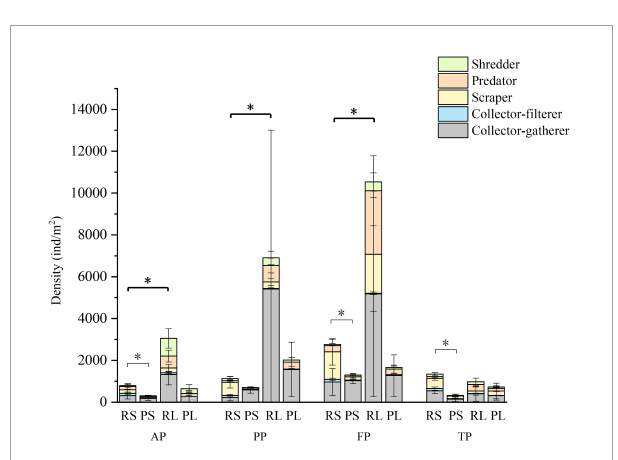
FIGURE5 Density of macroinvertebrates and functional feeding groups in the four types of substrates during the four periods. Light black asterisk indicated significant difference between riffle stones and pool sediments; dark black asterisk indicated significant difference between riffle stones and riffle litters. RS, riffle stones; PS, pool sediments; RL, riffle litters; PL, pool litters; AP, the autumn period; PP, the pre-freezing period; FP, the freezing period; TP, the thawing